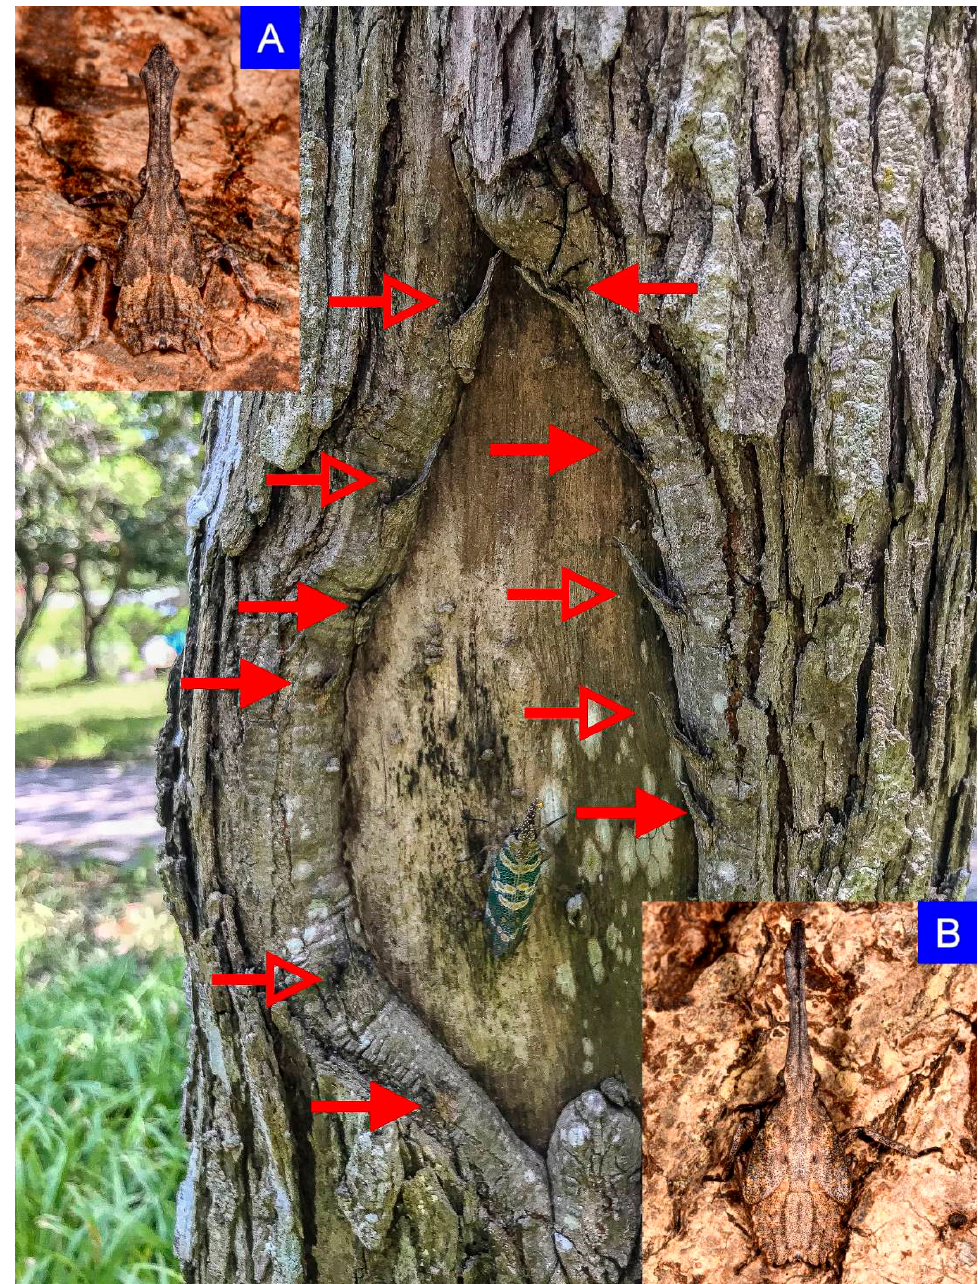
Figure 2. The nymphs of Pyrops candelaria may move to the lower part of the trunk in July. In this photograph, six fourth instars ( A ) and five fifth instars ( B ) were circling a newly emerged adult on the trunk of Triadica sebifera . The form and color of the nymph are cryptic, and like the remnants of broken twigs and barks. Each arrow points to a nymph. The fourth and fifth instars were indicated by solid and hollow arrows, respectively.